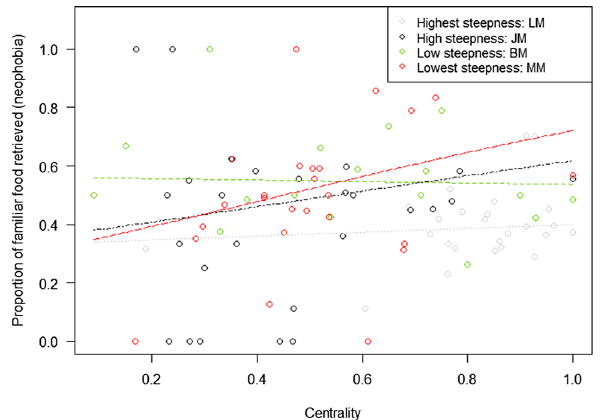
Figure 4. Mean proportion of familiar food retrieved by the study subjects in the social tolerance task (out of the total food retrieved by the subjects, as a measure of neophobia), as a function of their steepness and Eigenvector centrality (model 3). Circles represent the study subjects and are jittered to avoid overlap. Therefore, more neophobic subjects are those depicted in the upper part of the graph. The dashed lines depict the models, which have been back-transformed from the log-odds ratio scale and contain standardized